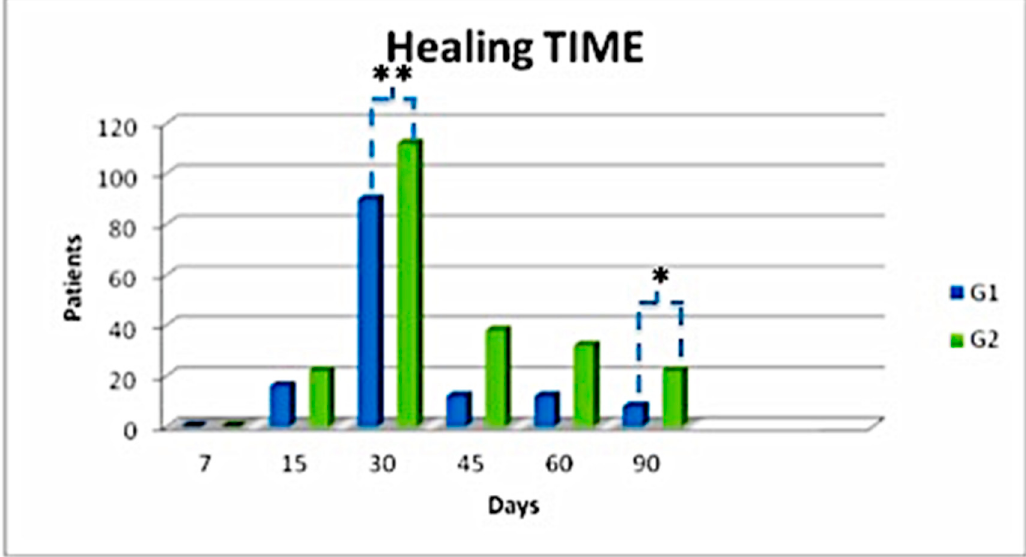
Figure 7. Healing time with follow-up care within 7, 15, 30, 45, 60, and 90 days. * p < 0.05; ** p <